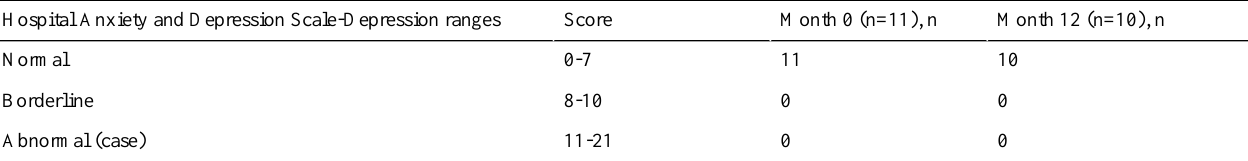
Table 14. Number of caregivers in each Hospital Anxiety and Depression Scale-Depression range group at months 0 and 12.